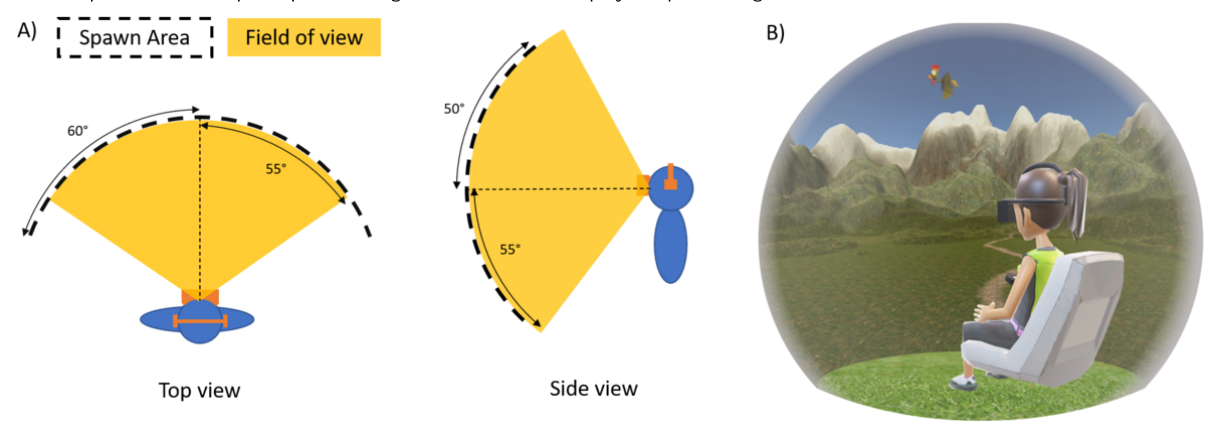
Figure 1. Immersive virtual reality game, with (A) the participant’s field of view (yellow) within the head-mounted display, which moved if the player (blue) turned his or her head, and the area where the target could appear (dashed line; spawn area), which was locked to the midsagittal plane; and (B) a schematic representation of a participant wearing the head-mounted display and performing the task.